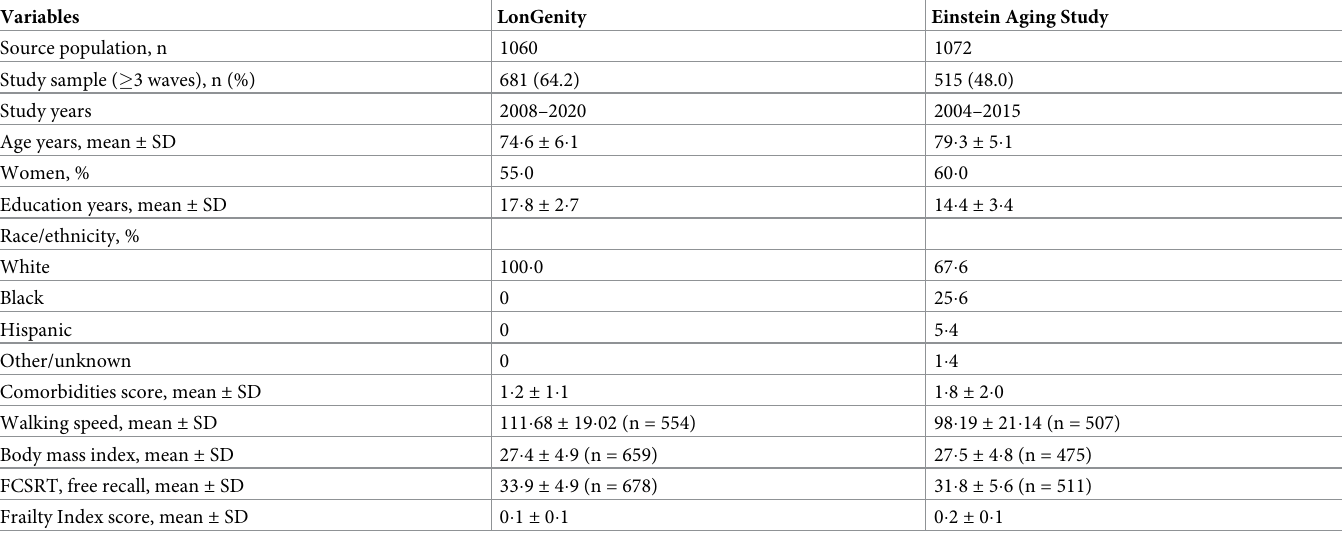
Table 1. Baseline characteristics of LonGenity and Einstein Aging Study cohorts. Variables LonGenity Einstein Aging